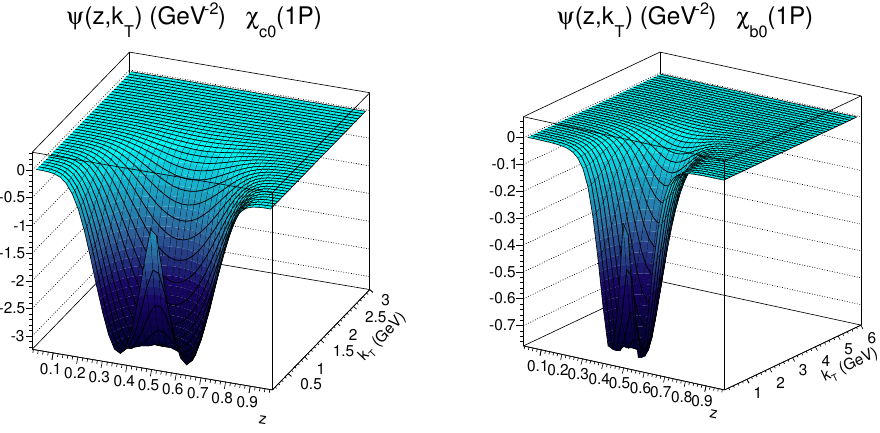
Figure 1 . Quarkonium wave functions u ( k ) for the (cid:31) c 0 and the (cid:31) b 0 for (cid:12)ve potentials.